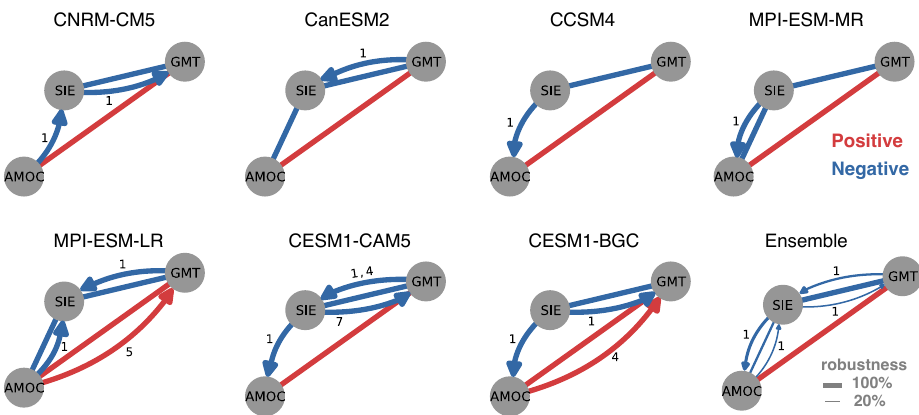
Fig. 6. Resulting time-series graphs for AMOC, GMT and SIE by applying a method introduced in Runge et al. (2012b). Based on the sign of the partial correlation as a result of the graph estimation algorithm, we denote positive (negative) partial correlations in red (blue). Direct links are indicated by curved lines with the associated time lags. Straight lines represent contemporaneous links at lag zero.